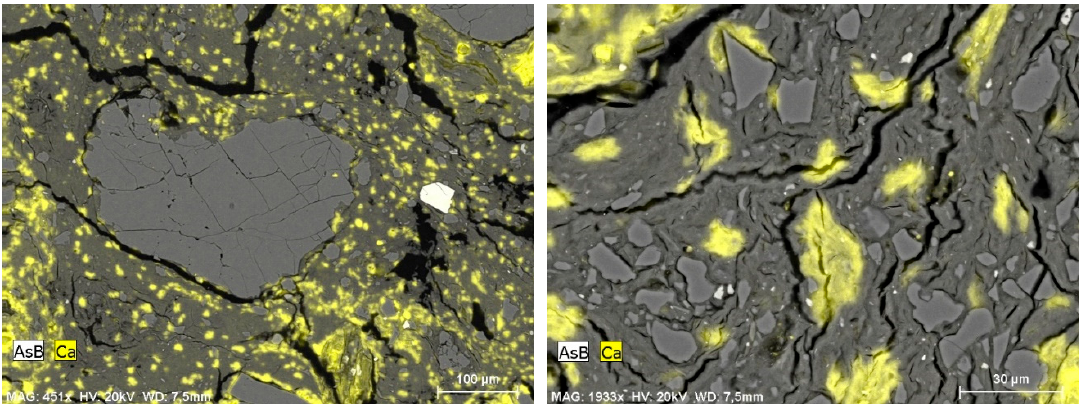
Figure 14. BSE image of a sample of MC X 9% CEM. Visible yellow calcium patches are not carbonates, but clay minerals rich in Ca.